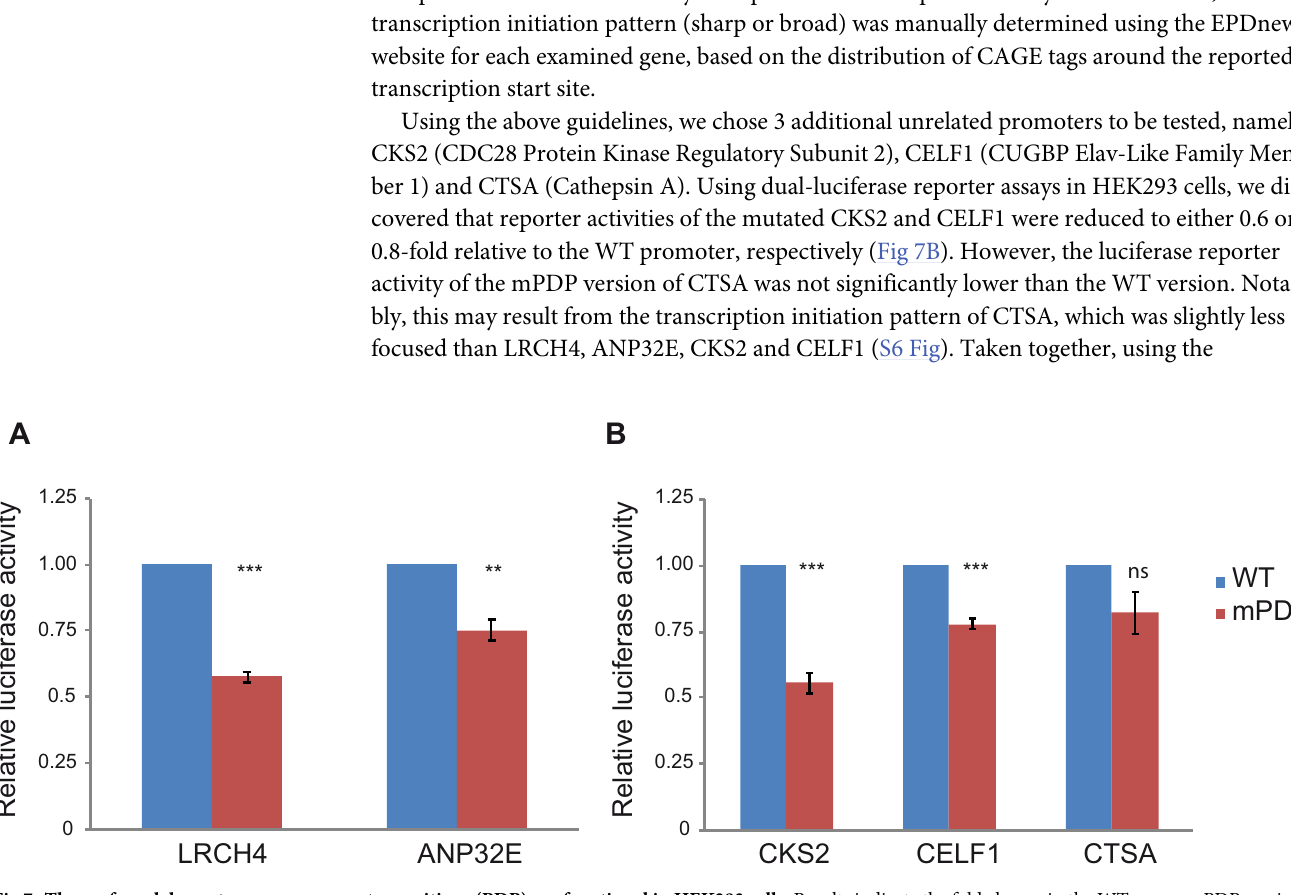
Fig 7. The preferred downstream core promoter positions (PDP) are functional in HEK293 cells. Results indicate the fold change in the WT versus mPDP version of the relevant promoter, tested by dual-luciferase assays in HEK293 cells. Each experiment was performed in triplicates, results represent 4-6 independent experiments ± SEM. ��� p < 0.001, �� p < 0.01, ns- not significant, calculated using Student’s t-test. Two candidate genes, LRCH4 and ANP32E (A), were first chosen based on their core promoter composition and conservation, as discussed in the Results section. (B) As the reduction in the LRCH4 reporter activity was more pronounced than that of the ANP32E gene, the characteristics of LRCH4 promoter were used as a reference (see Results section for the exact criteria), and the promoters of CKS2, CELF1 and CTSA were chosen for experimental examination. Numerical data are provided in S2